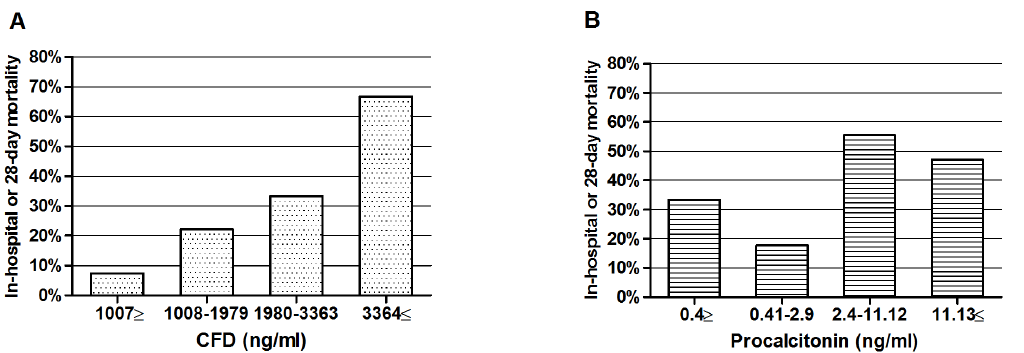
Figure 1. In-hospital or 28-day mortality percentage by CFD quartiles (A) and procalcitonin (PCT) quartiles (B) on hospital admission. CFD P-value for trend: p , 0.001, PCT P-value for trend: p=0.109.